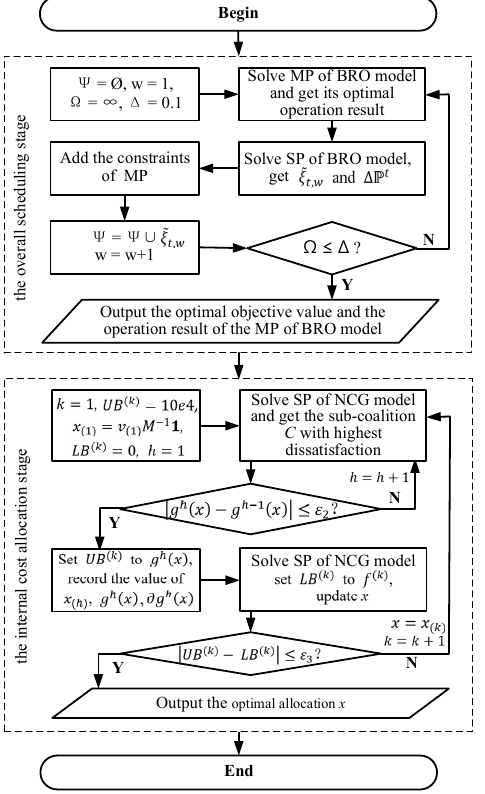
Figure 3. Algorithm flow chart for the model solving procedure.